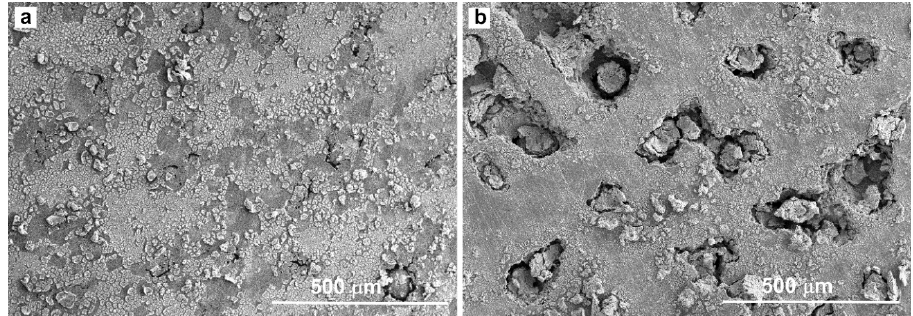
Figure 3. Morphology of pits on the corroded surface. ( a ): Initial stage of pits formation; ( b ): Final stage of pits formation.